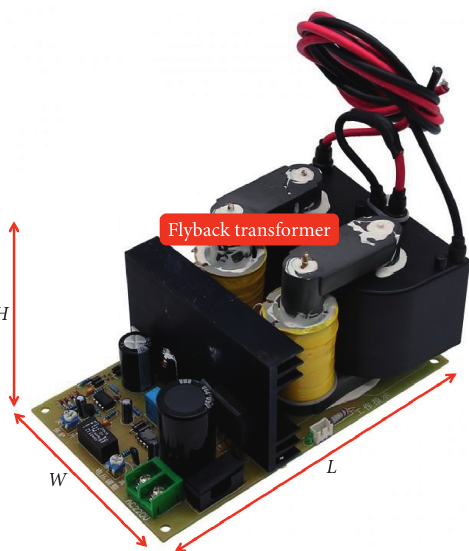
Figure 2: Model CX-300 of high-voltage source employed in this study. Two units of a flyback transformer were used to obtain 30kV (max), but still it is small in size. The dimension is 240mm × 145mm × 108 mm ( L × W ×